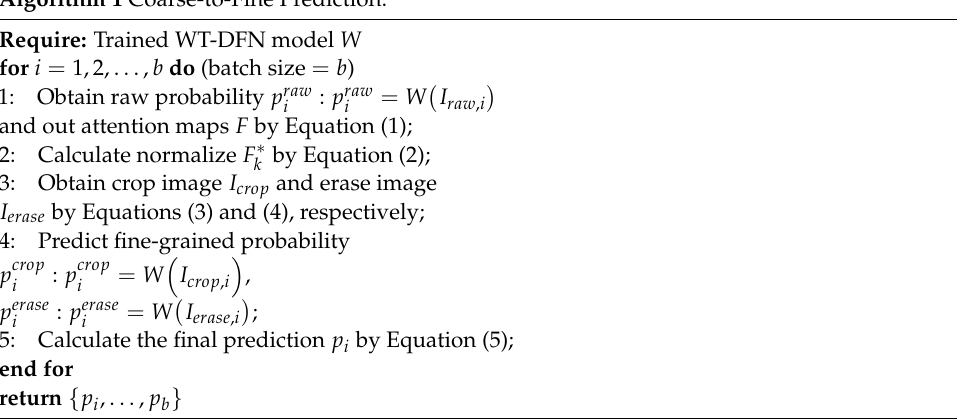
Algorithm 1 Coarse-to-Fine